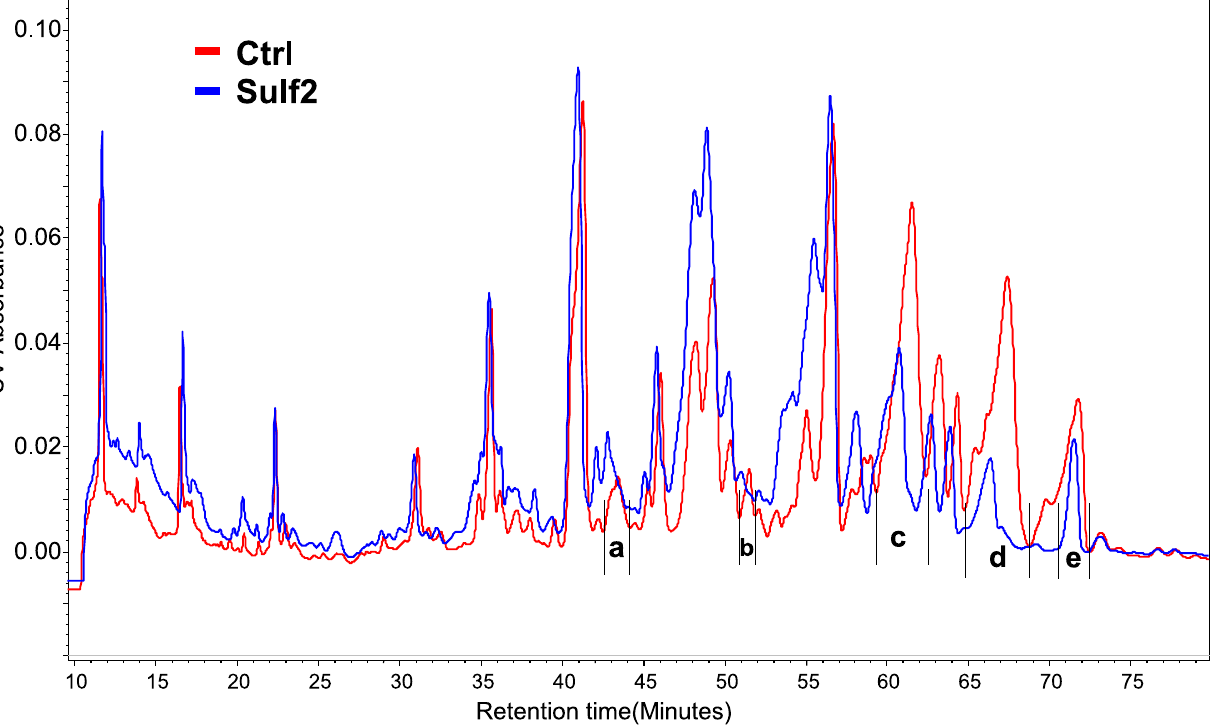
Figure 5. UV chromatograms of SAX separation of HS DP6 for control and HSulf2 digestion. Peak a , e indicates major fractions that change upon Sulf digestion.